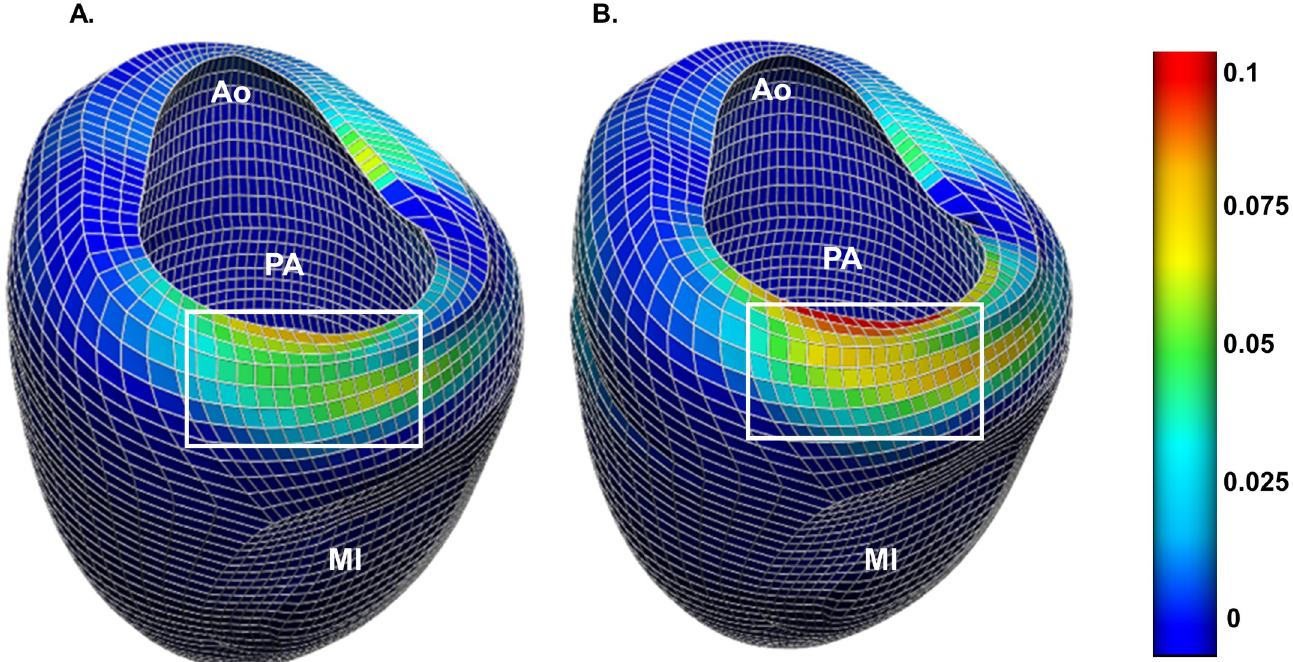
Fig 6. Color map of Δ in myocardial radial strain, Err, at end-diastole after simulated complete grasp MitraClip in the baseline LV (A) and in a dilated LV (B). Ao–left ventricular outflow/ aorta region. PA–posterior mitral annulus. MI–myocardial infarction.